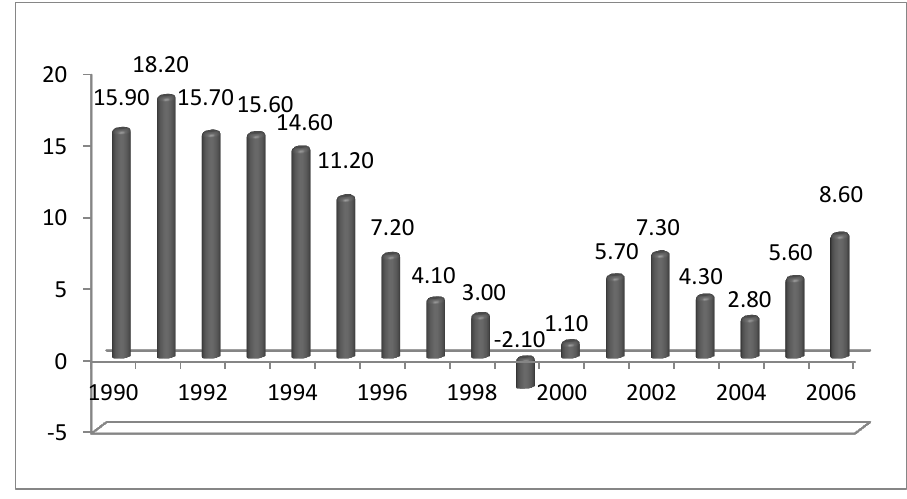
FIGURE 1: Trends in average earnings to total asset ratios (1990-2006) Source: